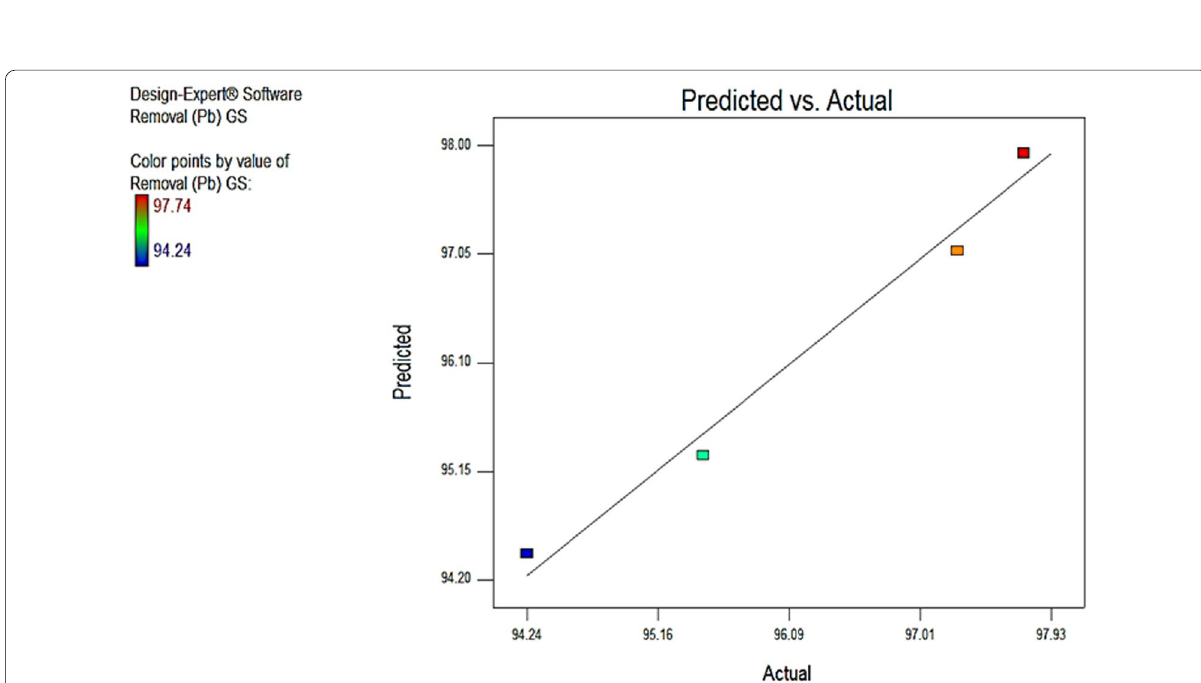
Fig. 3 A cross-validation plot of predicted response against actual values of response from selected factorial model on the removal of lead when groundnut shell residues are used as